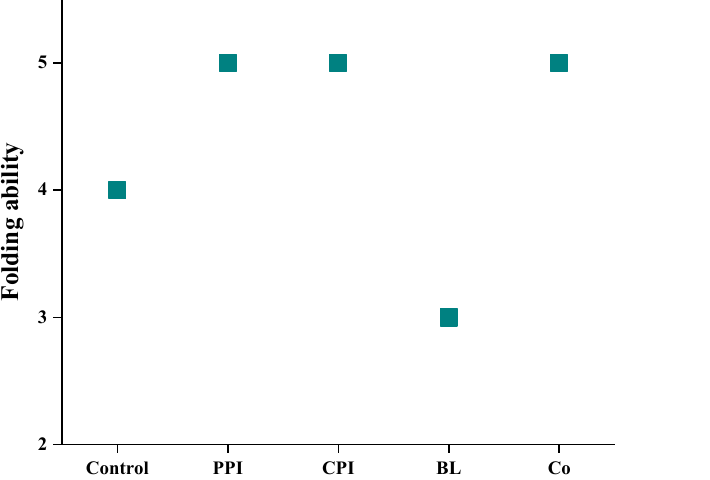
Figure 4. Effects of different protein pre-emulsified soybean oil on the folding capacity of fish sausage.